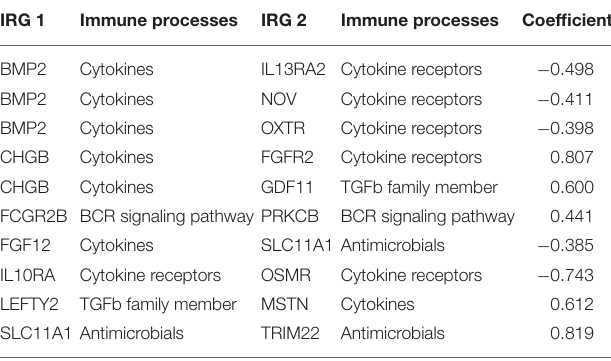
TABLE 2 | Information on the 10 immune-related gene pairs